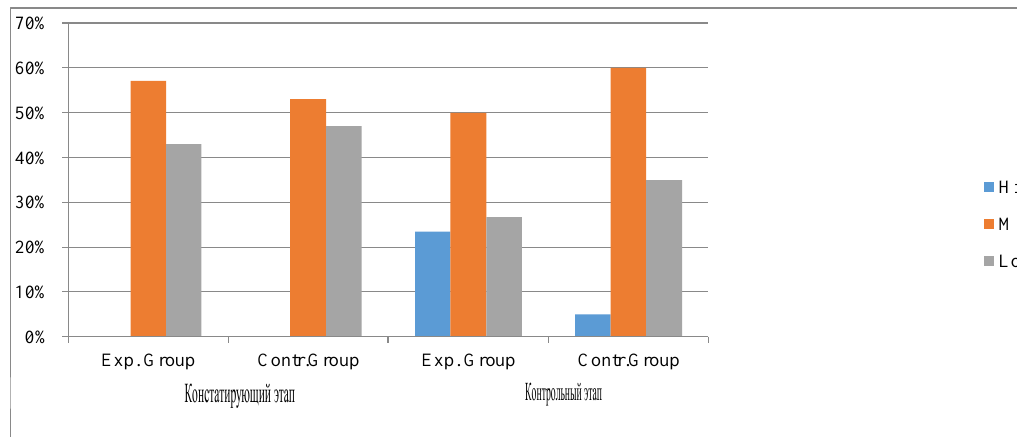
Fig. 8. Distribution of students by level of self-evaluation of correctional-developing competences formation at ascertaining and control stage of